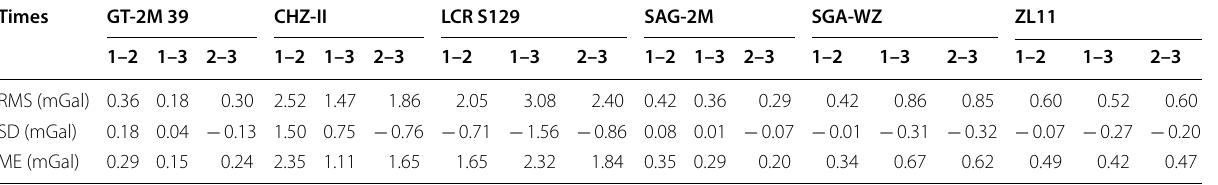
Table 4 Error statistics of different gravimeters on the repeated line L3 Times GT-2M 39